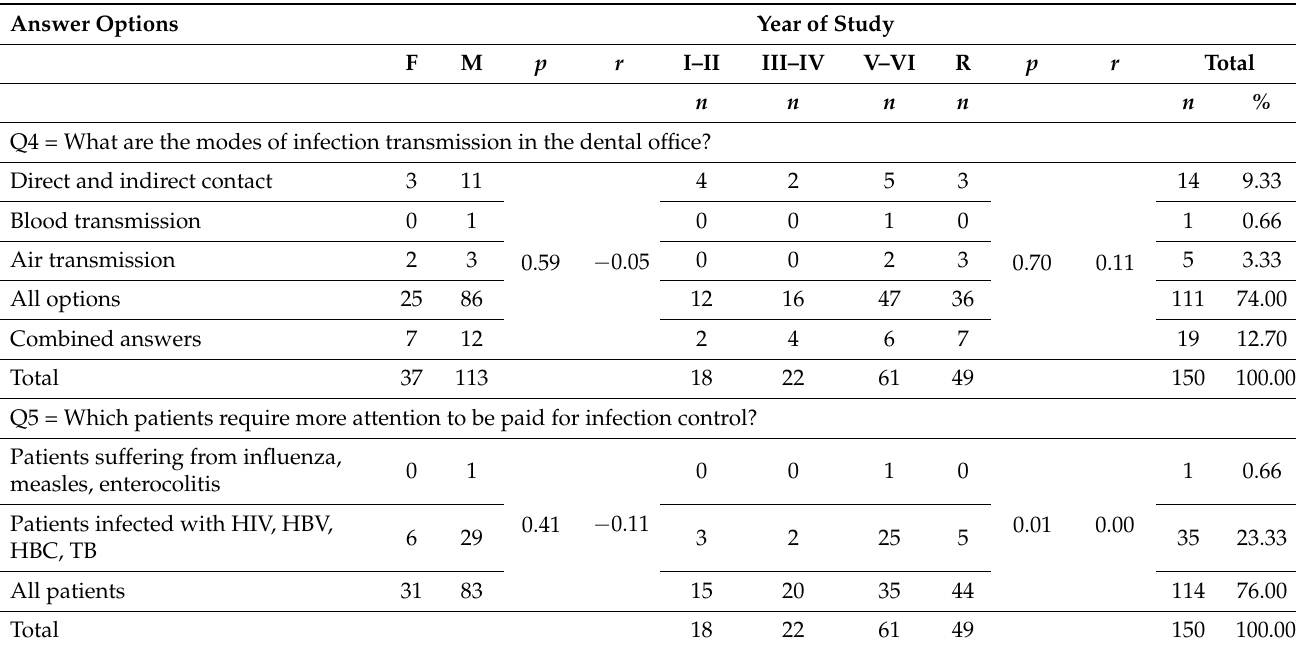
Table 2. Frequency distribution of answers to the questions about the modes of infection transmission in the dental office by gender and year of